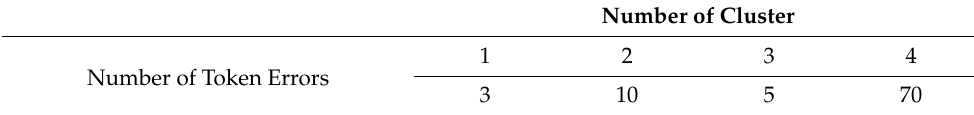
Table 7. Clustering variable of card code error (source: research analysis).